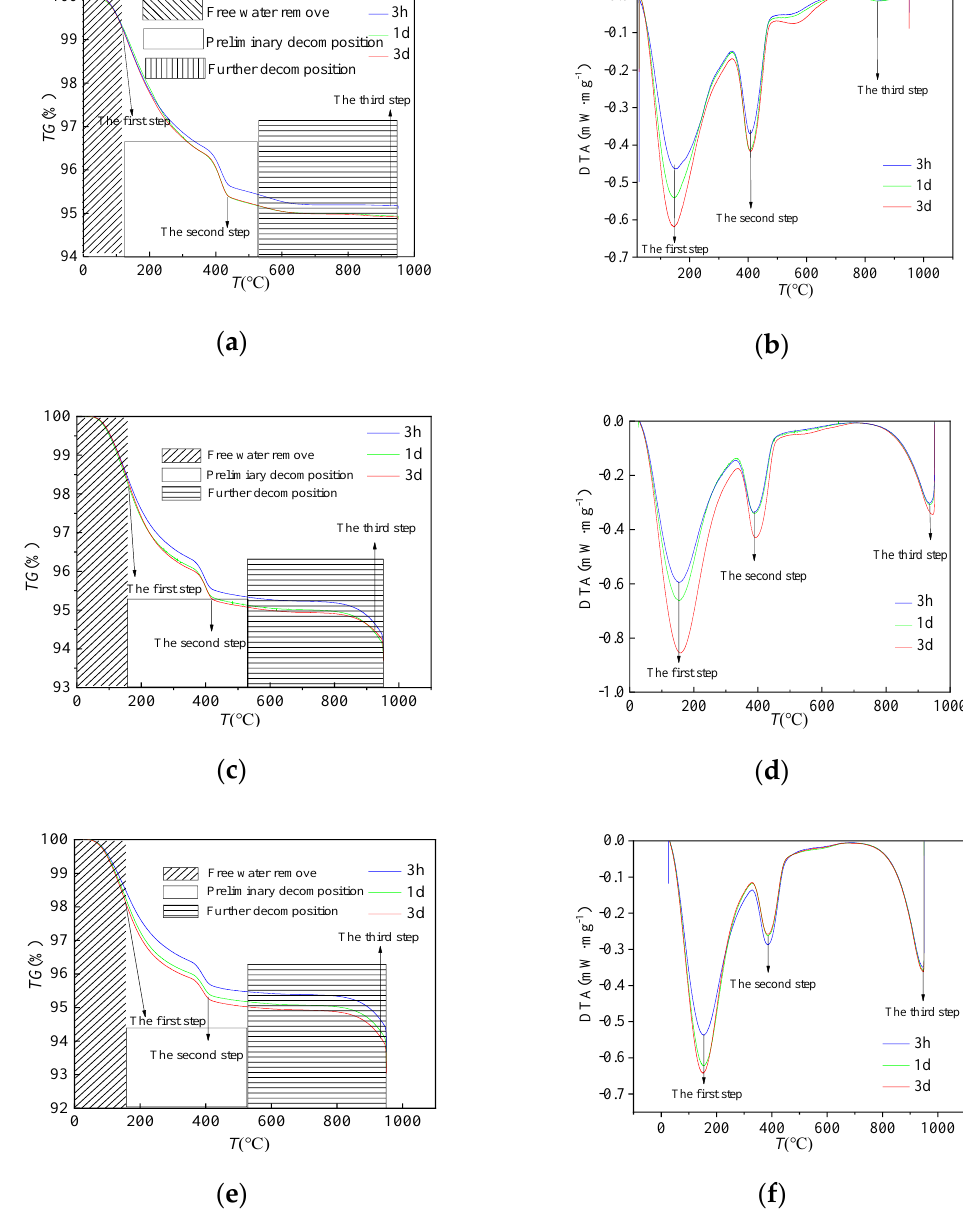
Figure 8. Thermogravimetric analysis curves of specimens. ( a ) TG curves of specimens with 0% MgCl, ( b ) DTA curves of specimens with 0% MgCl, ( c ) TG curves of specimens with 2% MgCl, ( d ) DTA curves of specimens with 2% MgCl, ( e ) TG curves of specimens with 4% MgCl, ( f ) DTA curves of specimens with 4% MgCl.